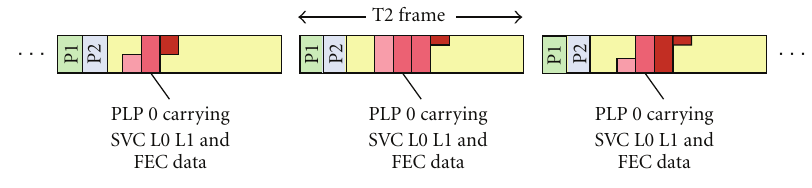
Figure 7: Transmission of data over one PLP.